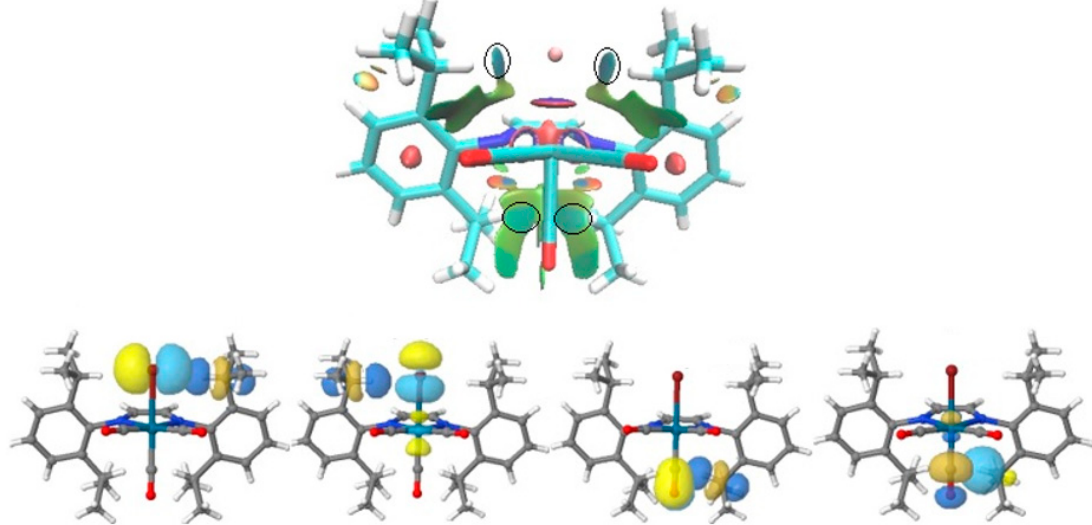
Figure 8. NCI plot of interacting dimer in 4 and the donor–acceptor interacting orbitals from NBO calculations through n p (Br) ... σ *, n p (Br) ... σ *, π (CO) ... σ *, σ ... π *(CO) from left to right, respectively. The interaction area is shown with black circles.